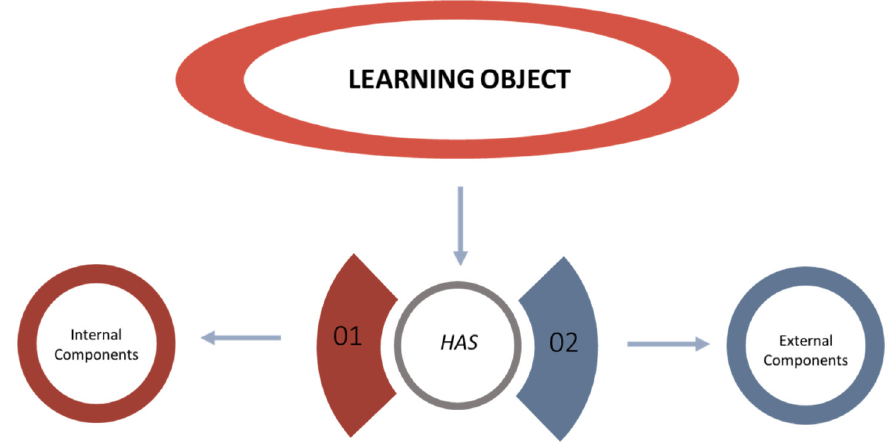
Figure 3. Taxonomy of learning objects. Composition. Source: based on Cuervo (2011); Castrillón (2011); Sánchez Medina (2014).